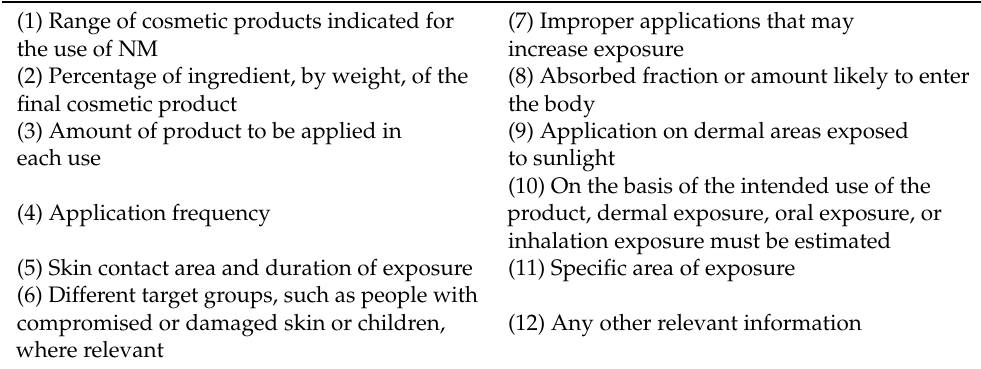
Table 1. Expected exposure conditions information